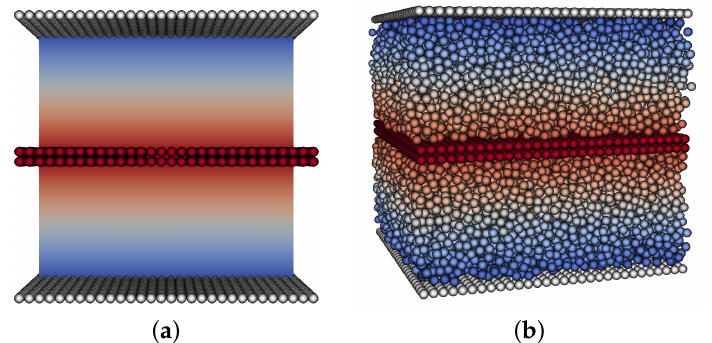
Figure 2. Modified computational shear flow experiment. Both upper and lower boundaries have zero no-slip conditions, with force applied to a layer of particles in the middle. This results in two mirrored sections with linear velocity profiles. ( a ) no particles , ( b ) particle volume fraction φ =